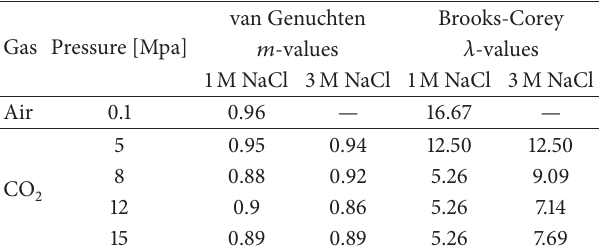
Table 2: 𝑚 - and 𝜆 -values obtained from van Genuchten and Brooks-Corey models.